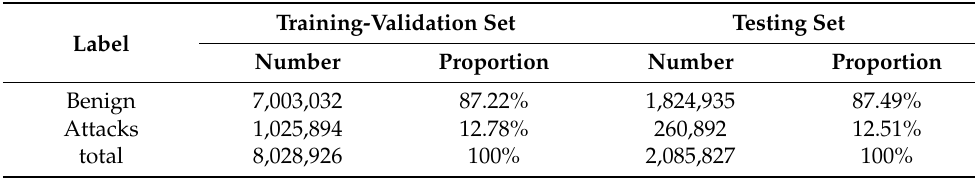
Table 4. CSE-CIC-IDS2018 binary classification of training-validation and testing data.